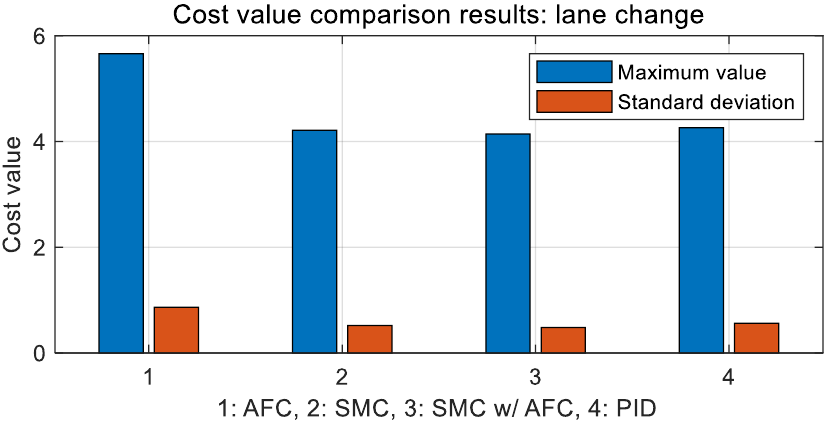
Figure 22. Results: cost value comparison in bar chart form for the lane change.